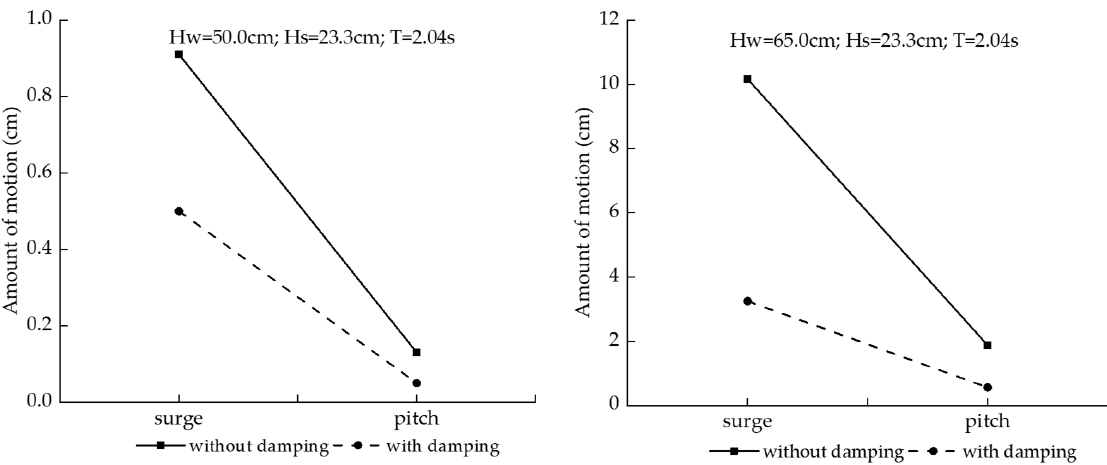
Figure 17. Comparison diagram of the surge and pitch of the towers with and without the damping device.